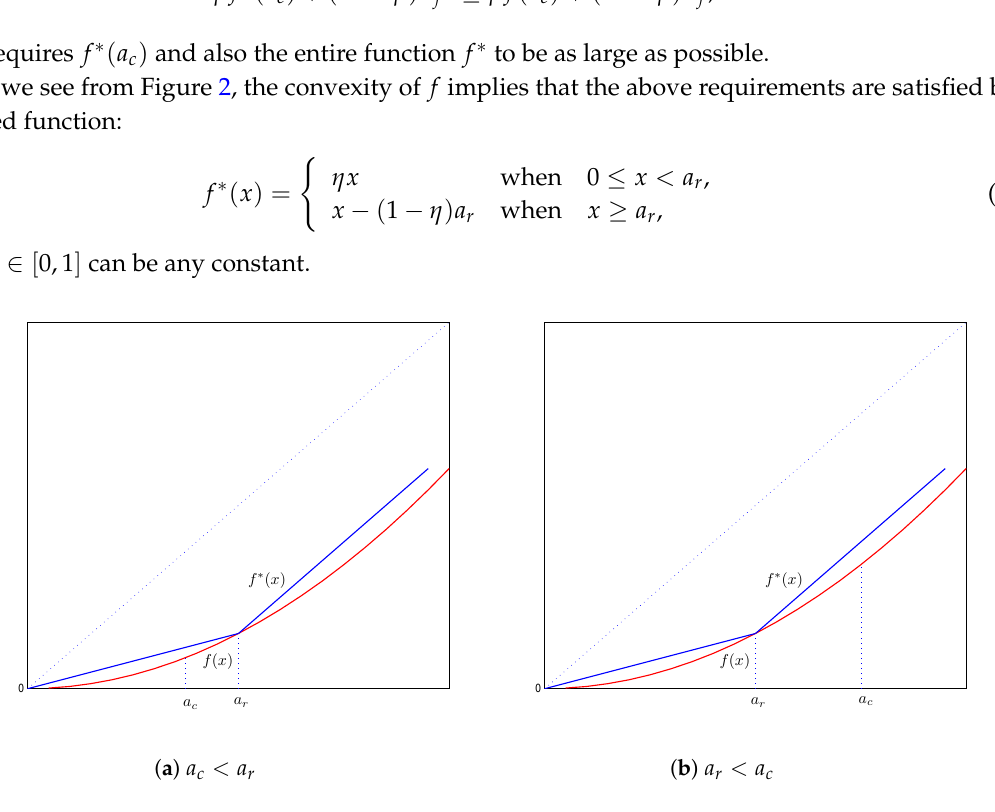
Figure 2. Optimal ceded functions in C 1 : Case